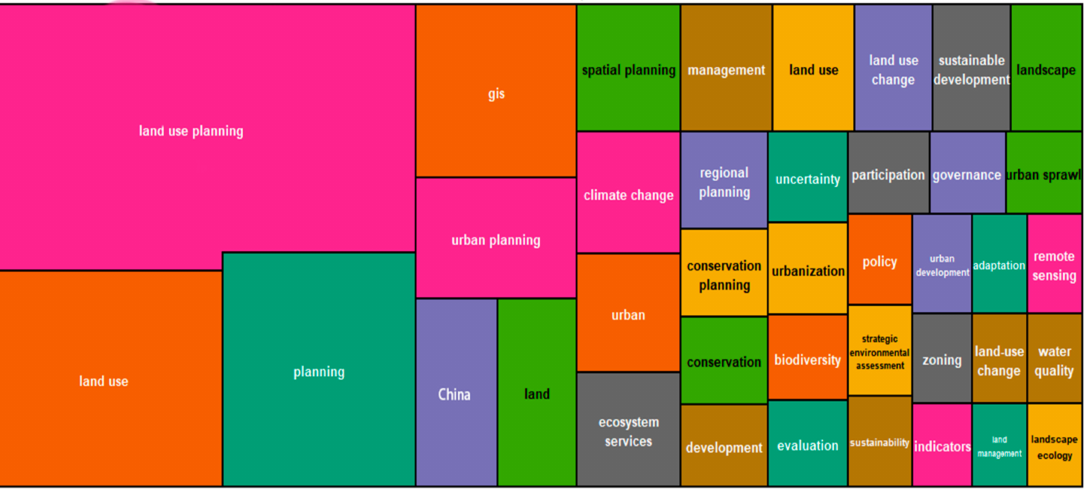
Figure 8. Word TreeMap of high-frequency keywords in the field of land use planning.